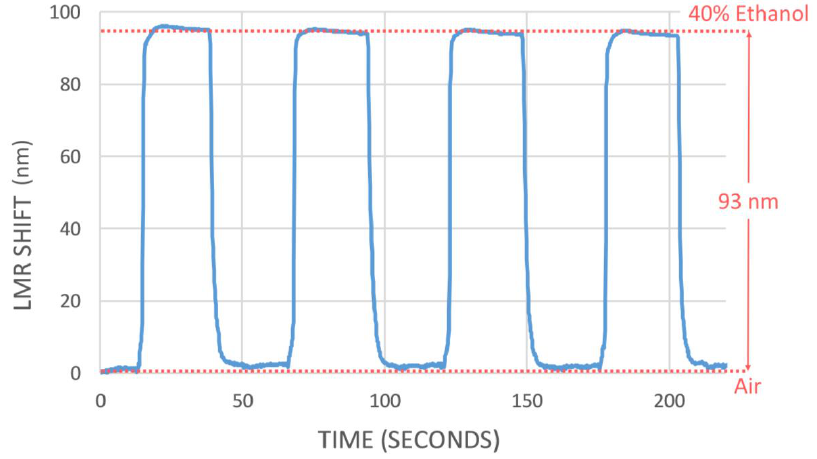
Figure 6. Dynamic response of SGO4b when it is immersed and withdrawn in a 40% v/v ethanol solution in water.